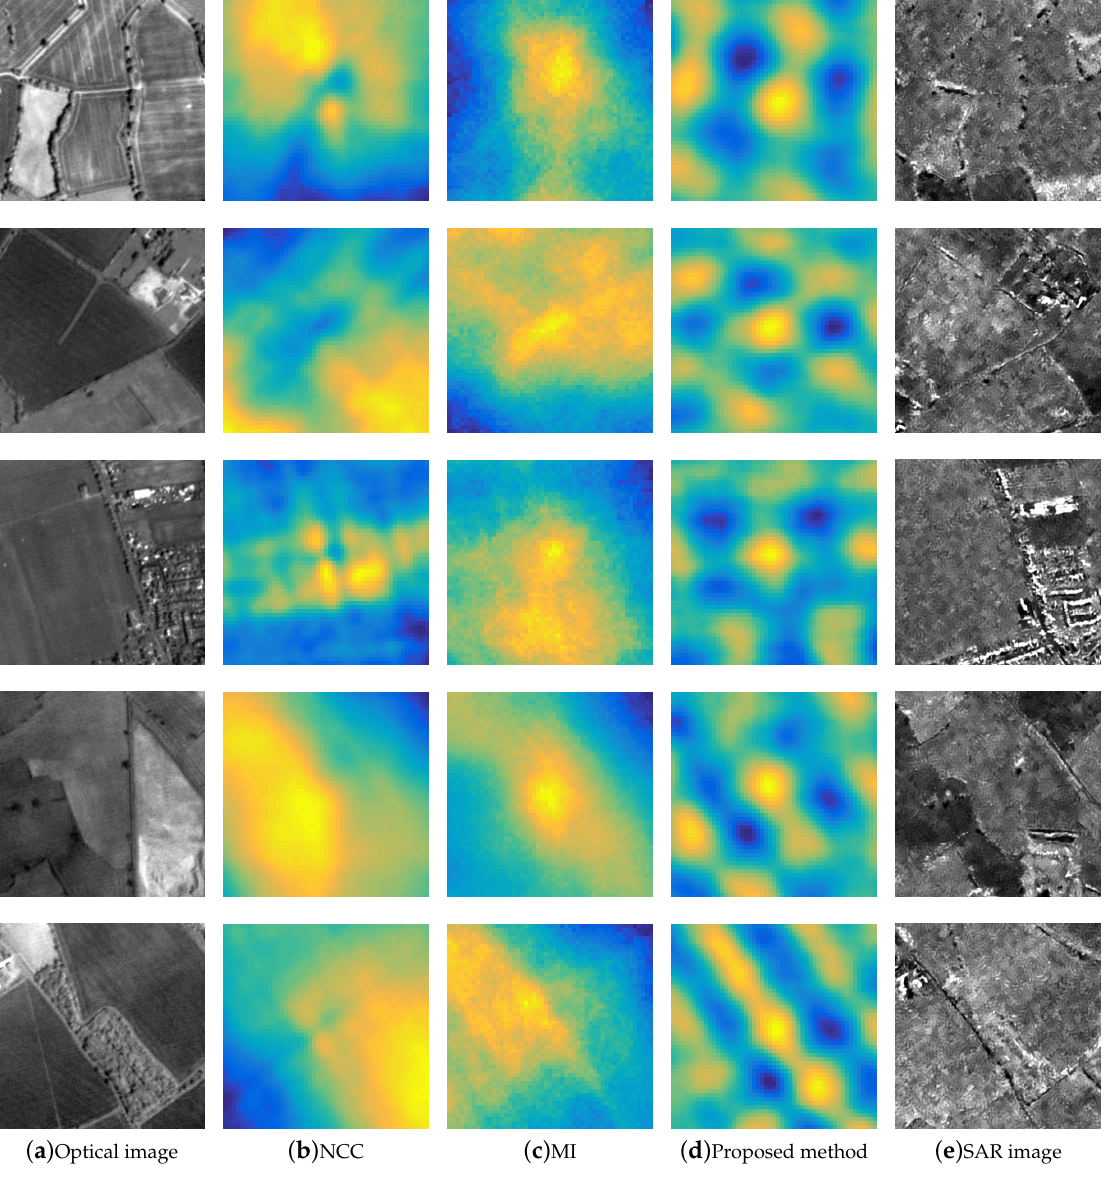
201 pixels), ( b ) the score maps ×